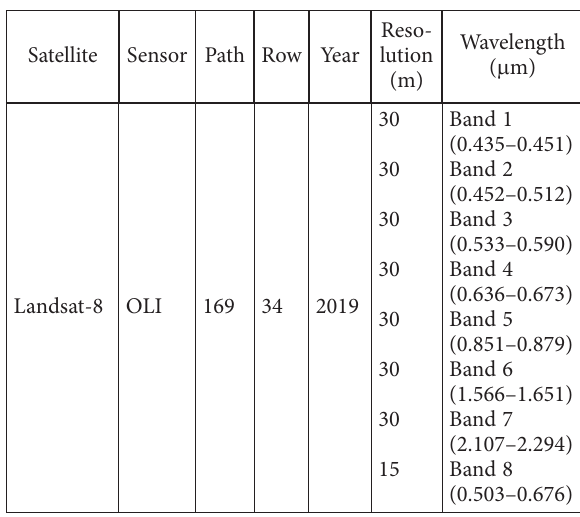
Table 1. The specifications of Landsat-8 OLI